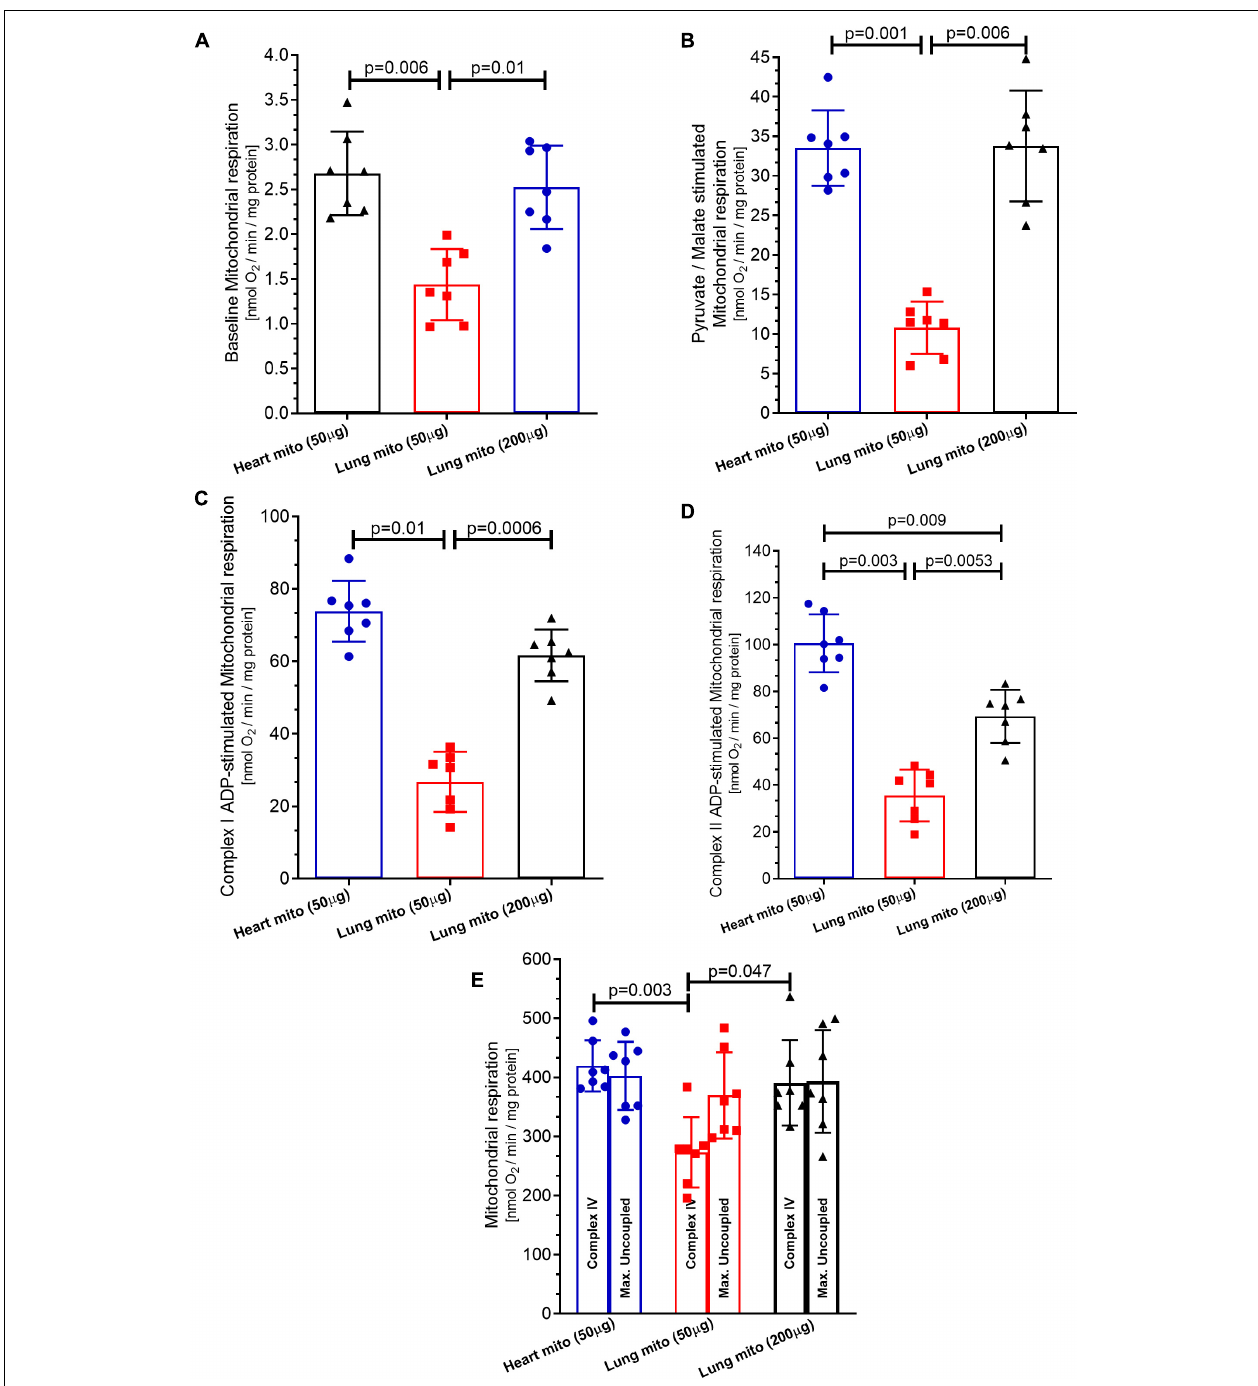
FIGURE 3 | Mitochondrial respiration. (A) Baseline respiration (state 1 complex 1), (B) pyruvate/malate stimulation (state 2 complex 1) respiration, (C) adenosine diphosphate (ADP) stimulation (state 3 complex 1) respiration. (D) Complex II respiration was stimulated with succinate and using the complex I inhibitor Rotenone. (E) Complex IV respiration stimulated with N,N,N,N-tetramethyl-p-phenylenediamine dihydrochloride (TMPD) and ascorbate and maximal uncoupled oxygen uptake induced by carbonyl cyanide 4-(trifluoromethoxy)phenylhydrazone (FCCP) of isolated mitochondria from mice heart and lung. Heart mito (50 µ g) represents the group of isolated mitochondria from hearts. Lung mito (50 µ g) indicates the group of isolated mitochondria from lungs with loading of 50 µ g. Lung mito (200 µ g) signals the group of isolated mitochondria from lungs with loading of 200 µ g. Each symbol represents one animal. The values are reported as mean ± standard deviation. Horizontal square brackets indicate significantly different differences and the corresponding p